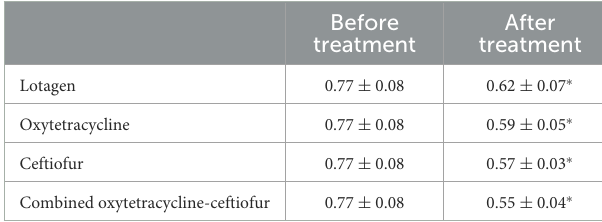
TABLE 2 Results of uterine thickness (cm) before and after treatment of endometritis in dromedary camels using different treatment regimes. Before